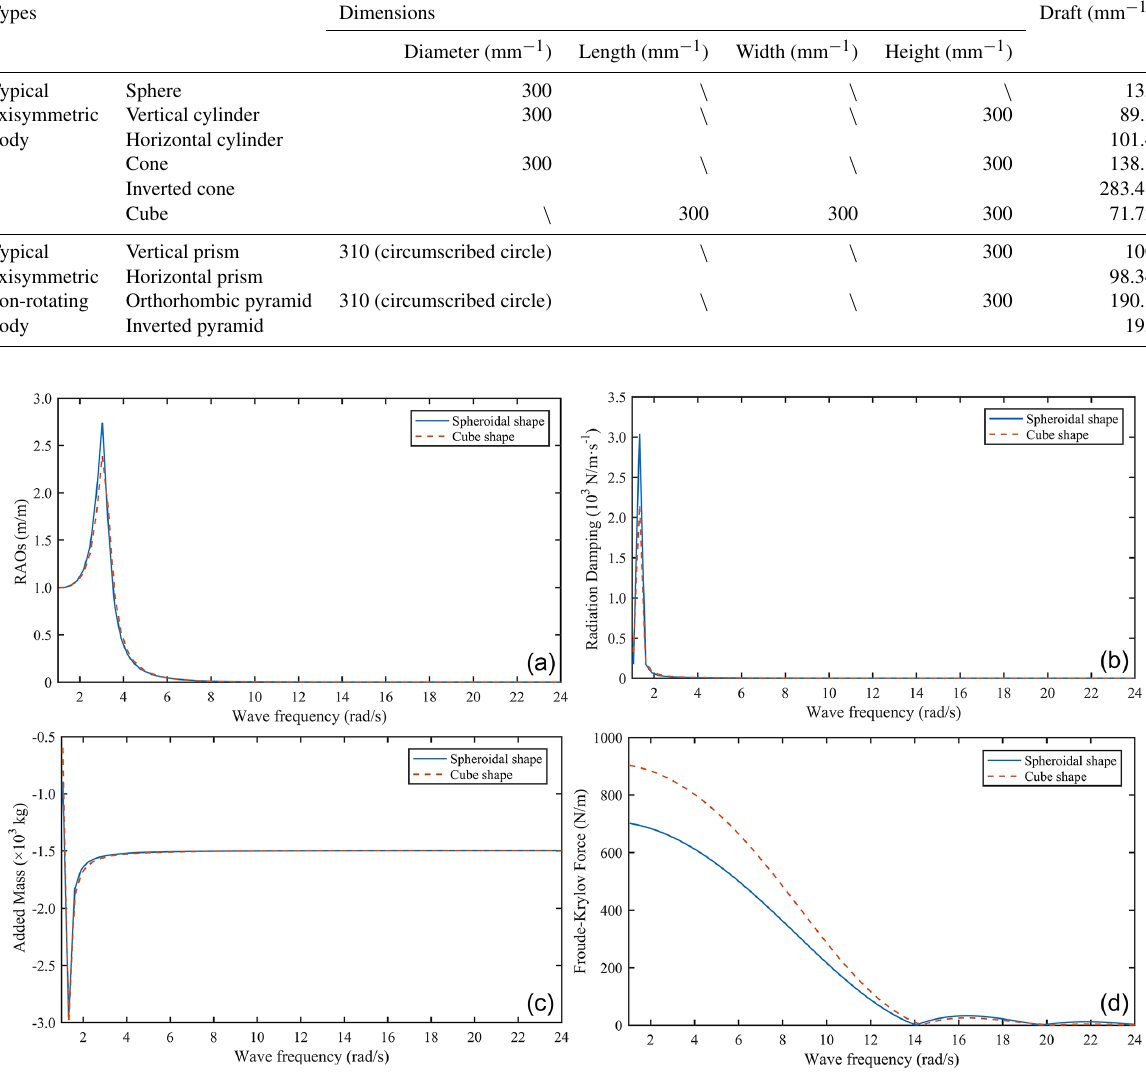
Figure 3. Energy efficiency comparison of spherical and square floating bodies. (a) RAOs. (b) Radiation damping. (c) Added mass. (d) Froude–Krylov